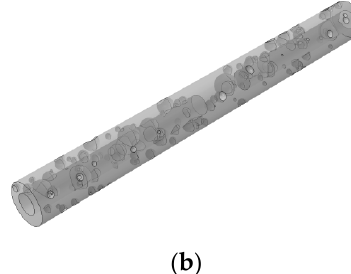
Figure 5. Diagrams of grouting defects models. ( a ) 5% defects model. ( b ) 10% defects model.